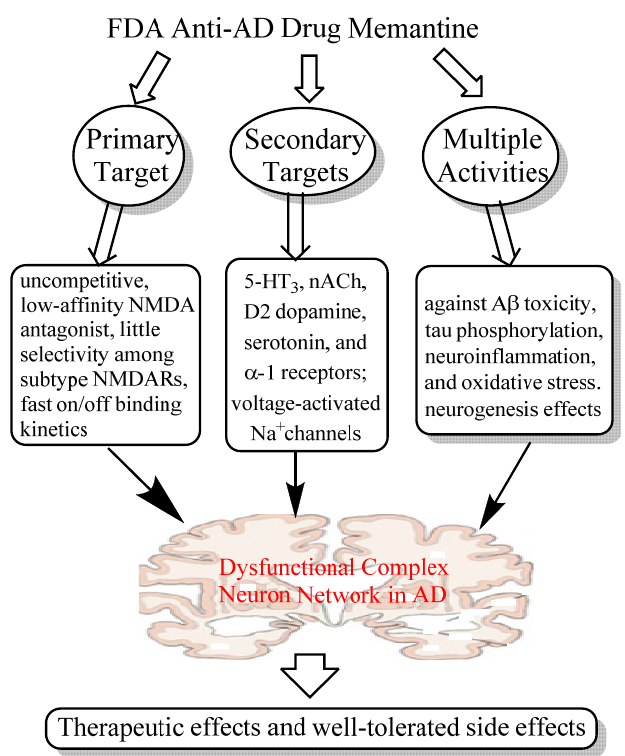
Figure 1. A system network view of memantine action: memantine interacts with multiple primary and secondary targets and exerts its manifold neuroprotective effects, which may synergistically contribute to its therapeutic effects and well-tolerated profile in the